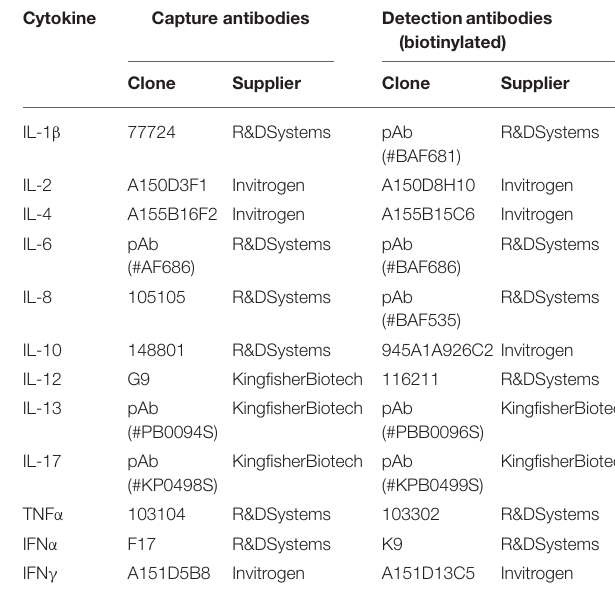
TABLE 4 | Antibodies used for